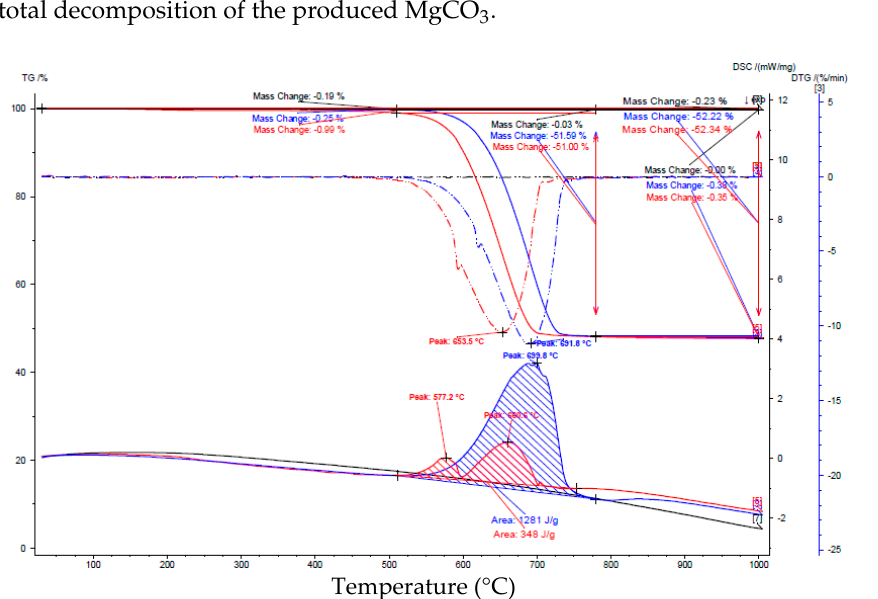
Figure 11. TGA and DSC Analysis of formed product after carbonation of synthetic magnesia (20 °C/min, nitrogen, Exp. 4).